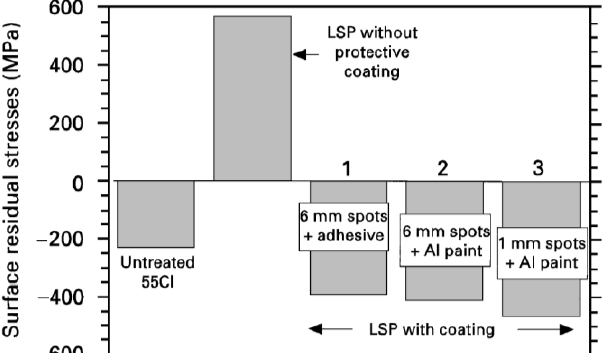
Figure 4. Average residual stress values determined at the surface of notched fatigue samples with different ablative layers and spot sizes peened with power density of 5 GW/cm 2